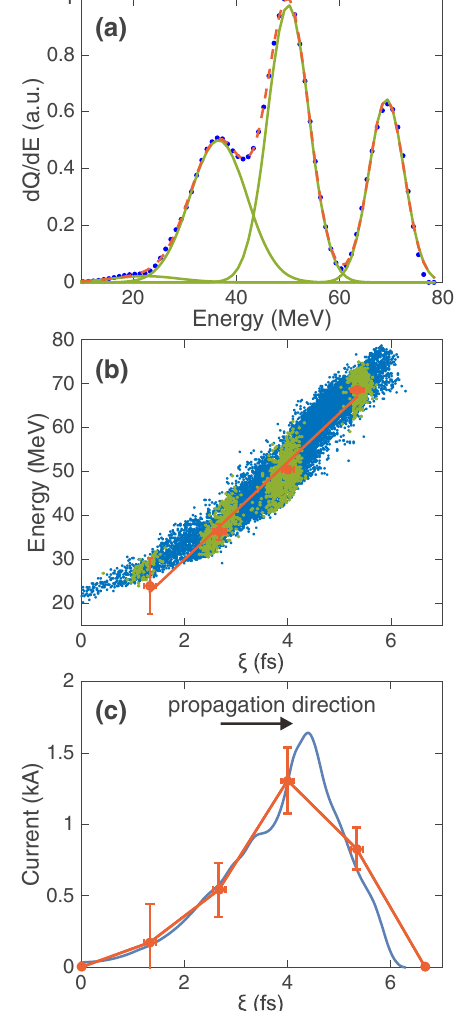
FIG. 2. The blue dots in (a) are the modulated energy spectrum corresponding to Fig. 1(d). It is fitted by four Gaussian peaks (the green solid lines) and the red dashed line represents the super- position of these four peaks. (b) The longitudinal phase space of the bunch. The blue and green dots represent the electrons received by the virtual energy spectrometer without and with the slit, respectively. The red dots are calculated from (a) and the red line is a linear fit. (c) The beam current profile. The blue line is the current profile directly obtained from the simulation, while the red dots and line is the recovered current profile using the fitting data in (a). The error bars in (b) and (c) arise from the fluctuations induced by the variation of the slit width (from 1.4 mm to 2.2 mm) and the displacement between the bunch center and the slit center (from − 0 . 8 mm to 0.8